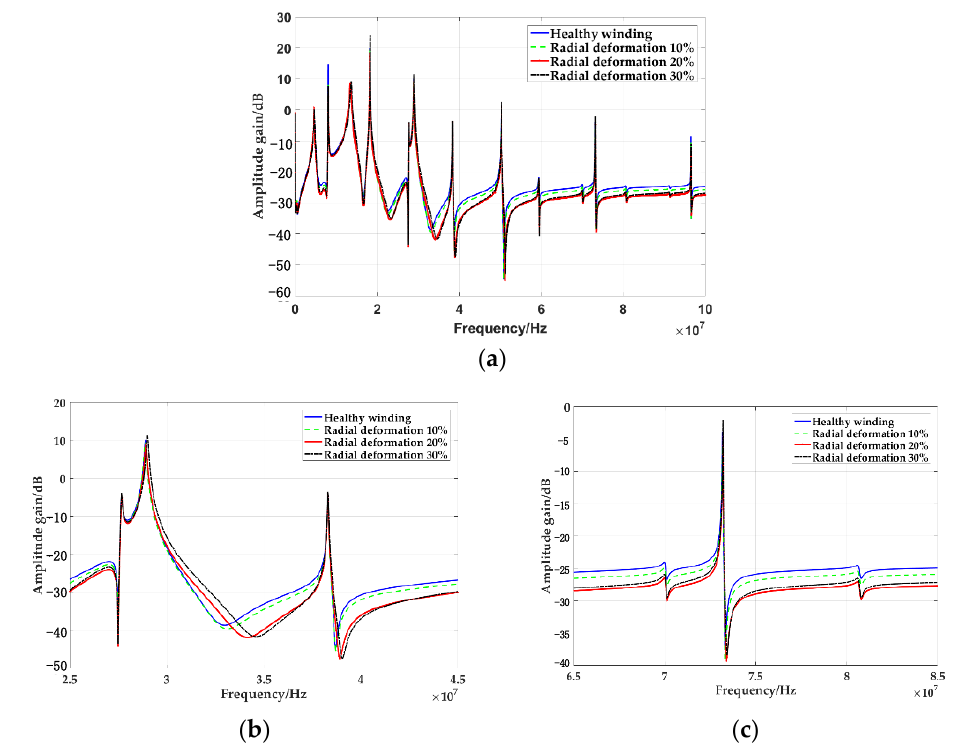
Figure 13. Frequency response curve of winding radial deformation: ( a ) full-band frequency response curve, ( b ) low-frequency partial amplification frequency response curve, and ( c ) high-frequency partial amplification frequency response curve.